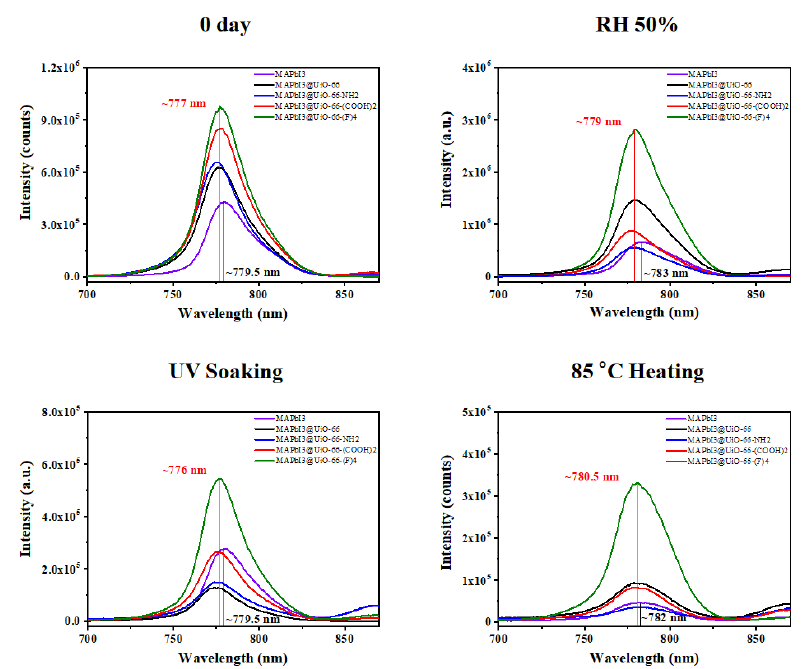
Figure 7. The PL spectra of the pristine MAPbI 3 and MAPbI 3 @UiO-66 nanocomposite samples before and after humidity, UV-light, and heat aging for two weeks.